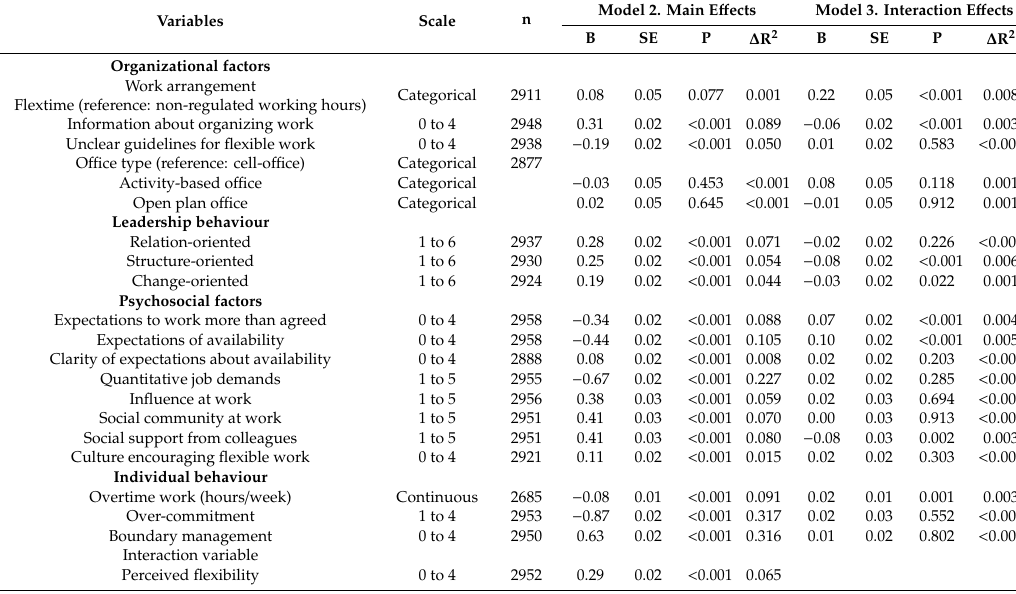
Table 3. Associations between occupational factors and individual behaviours, and work-life balance (WLB). Results in terms of B, standard error of B, and contribution to explained variance ( ∆ R 2 ) of multiple linear regression analyses addressing main e ff ects (model 2) and interactions with perceived flexibility (model 3). All models were adjusted for age, gender, level of education, years of employment, marital status, children at home, and position (manager or